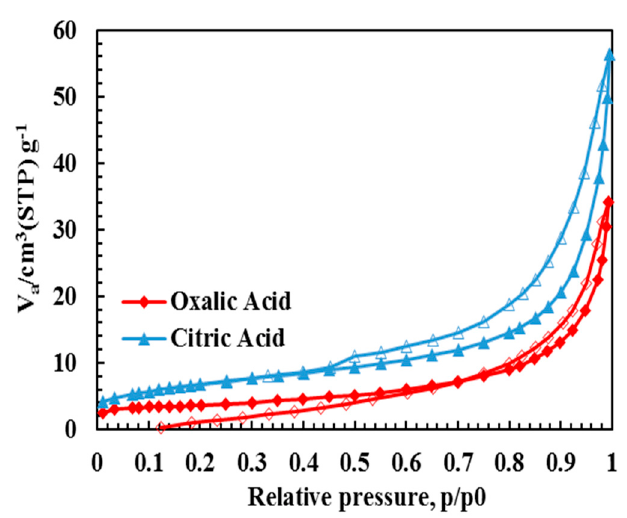
Figure 5. Adsorption (filled symbols)-desorption (open symbols) isotherms of the LVP